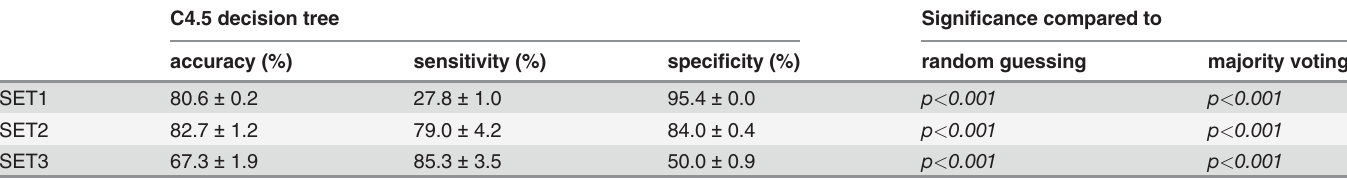
Table 6. Performance measures for the C4.5